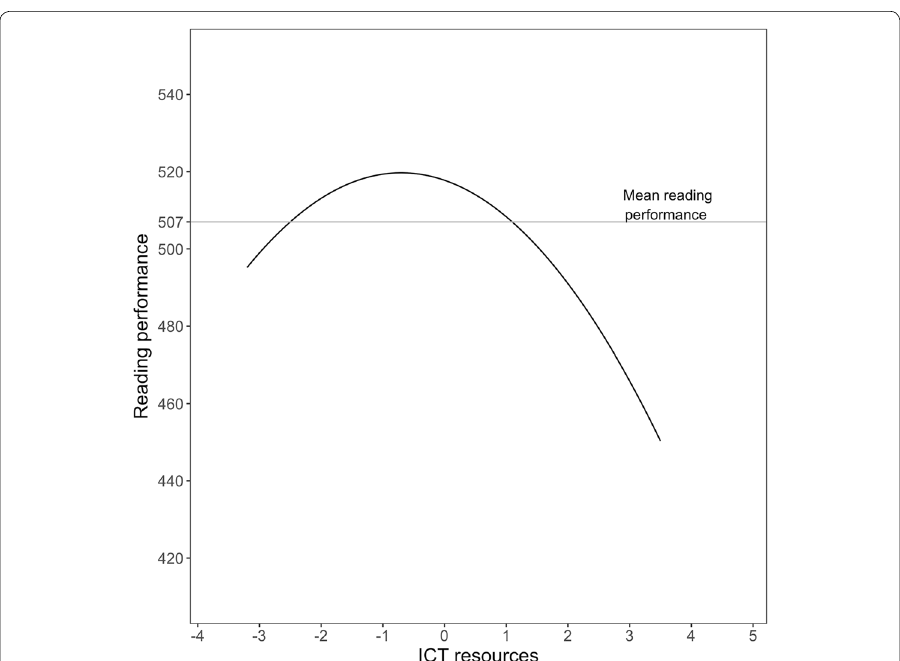
Fig. 1 Relationship between the availability of ICT resources and digitally assessed reading